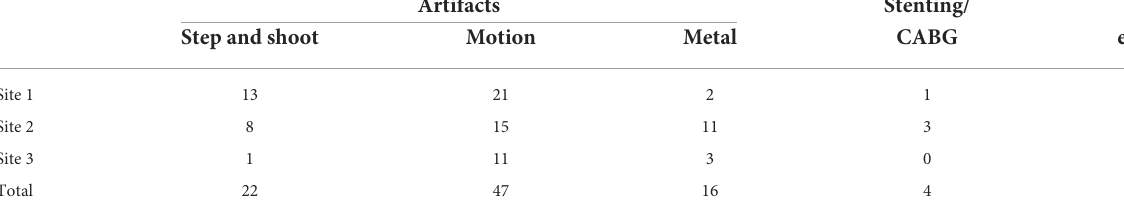
TABLE 1 Patients were excluded due to artifacts, i.e., severe step-and-shoot artifacts, severe cardiac motion artifacts or artifacts caused by metal implants. Artifacts Stenting/ Total Step and shoot Motion